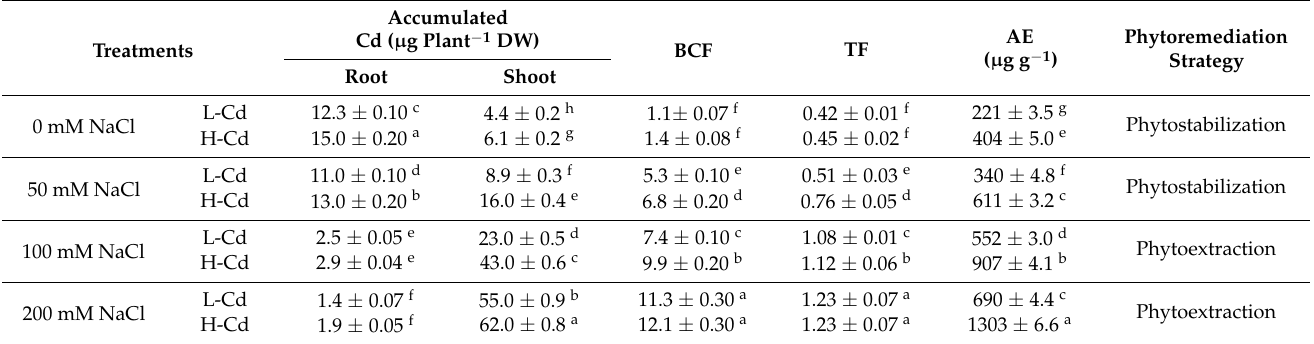
Figure 2. Concentrations in mg g − 1 DW of leaf sodium (Na), potassium (K), calcium (Ca), and shoot and root cadmium (Cd) ( a , b , c , d , respectively) in Salicornia fruticosa exposed to nutrient solution containing 0, 25, and 50 μg L − 1 Cd (0-Cd, L . -Cd, and H . -Cd, respectively) without or with 50, 100, and 200 mM NaCl. Each value is the average of four replicates ± SE. For shoot and root Cd concentration, values of 0-Cd were removed from ( d ), as no Cd was detected in 0-Cd treatment. Values bearing different letters are significantly different at p < 0.05 based on Tukey’s test. DW: dry weight. Table 2. Effect of NaCl on some Cd phytoremediation parameters in Salicornia fruticosa : accumulated cadmium root and shoot ( µ g plant − 1 DW); bioaccumulation factor (BCF); translocation factor (TF); and absorption efficiency (AE; µ g g − 1 ). Values bearing different letters are significantly different at p < 0.05 based on Tukey’s